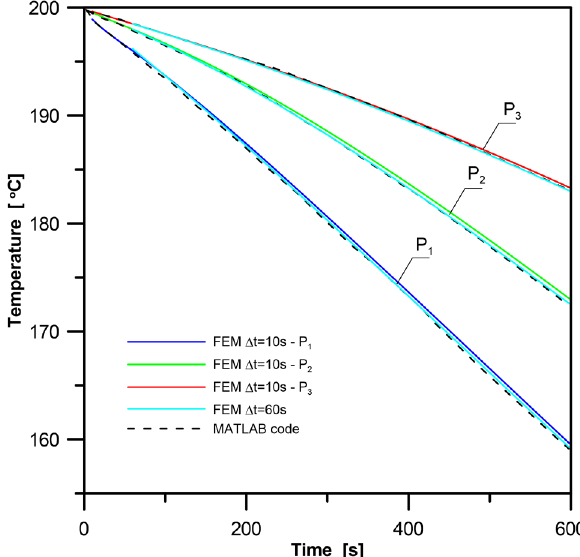
Figure 4: (3, 1), (62, 1), and (191, 1). A reduction in the time step to Δ t = 10 s involved a slight difference in the temperature transients.